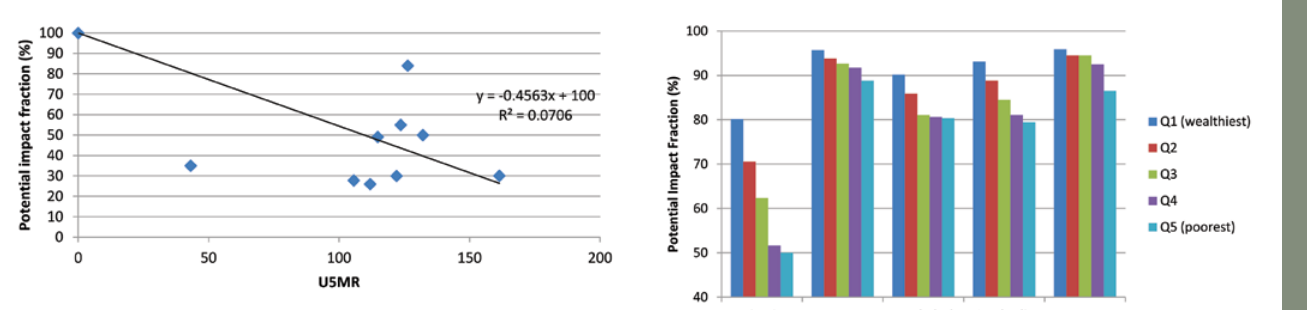
Figure 8 Effectiveness/Potential Impact Fraction (PIF) model for community case management (CCM).